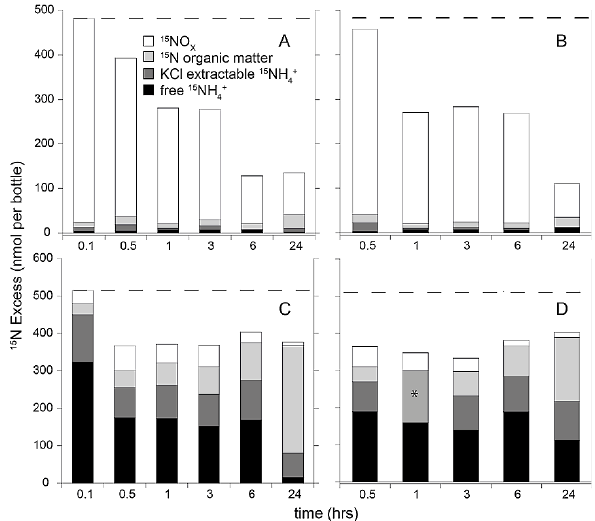
Fig. 5. Relative distribution of labelled N in different pools of ni- trogen. (A) 15 N-nitrate addition in light and (B) dark; (C) 15 N- ammonium addition in light and (D) in dark. Asterisk in plot (D) : sediment-bound ammonium and organic matter were not deter- mined separately. The amount of the pool “missing label” was cal- culated by difference in comparison to the initial label addition, in- dicated by the dashed line (see text for details).